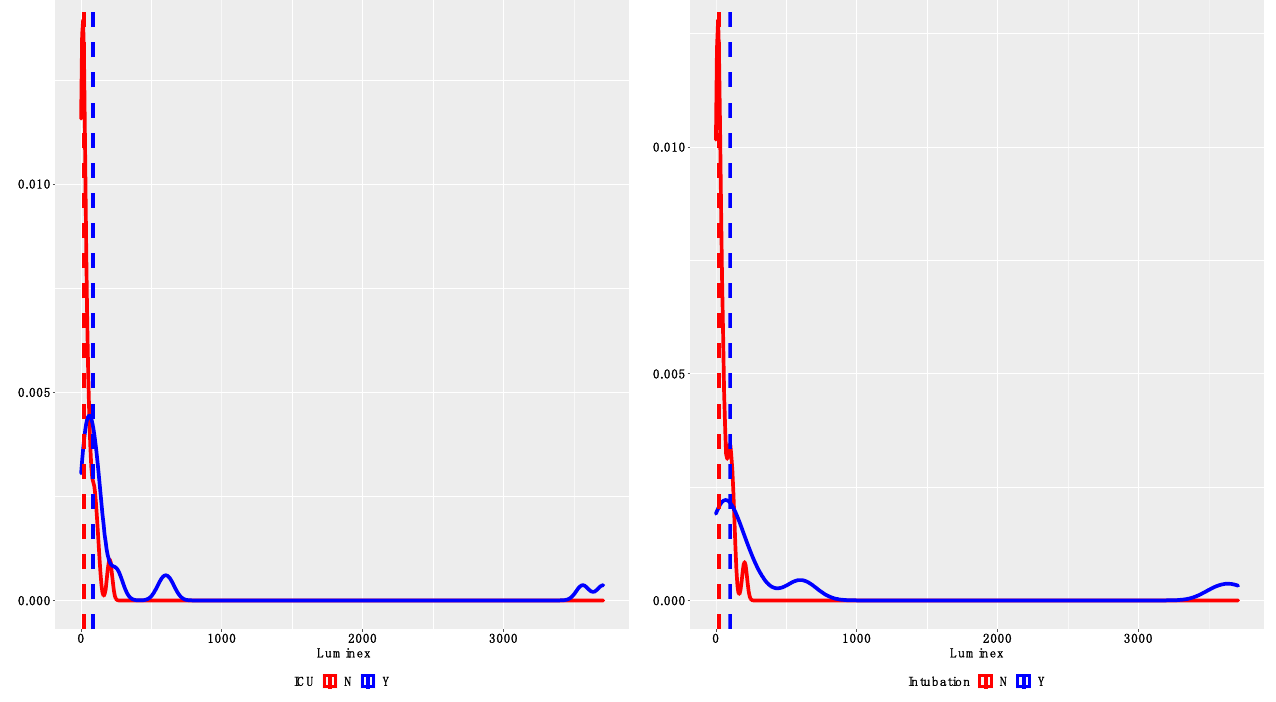
Figure 5. Luminex (red), QDTI10x (green), and QDTI80x (blue). ( A ) ROC for patients admitted to the ICU. ( B ) ROC for patients requiring intubation. 4. Discussion In this study, a strong correlation coefficient regarding diagnostic performance has been demonstrated between the QDTI assay and the Luminex assay, indicating that the novel QDTI platform provides firm evidence of statistical equivalence as compared to Luminex. It is noteworthy to mention that IL-6 levels measured using plasma are known